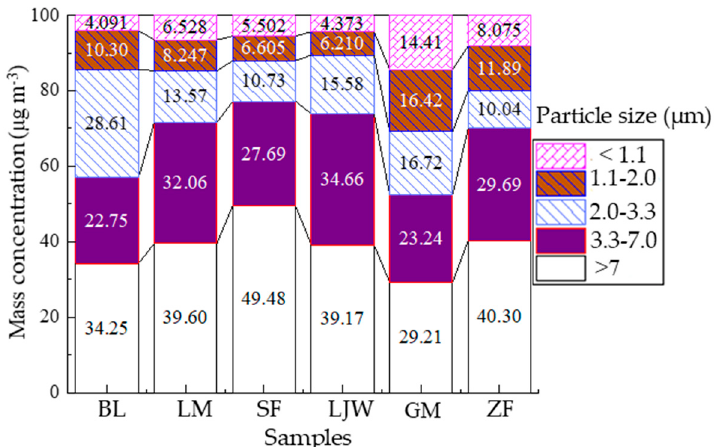
Figure 5. Mass concentration percentages of particles emitted from RCC (%) (Bole coal (BL), Luomu coal (LM), Shunfa coal (SF), Lijiawu coal (LJW), Guangming coal (GM), and Zongfan coal (ZF)).